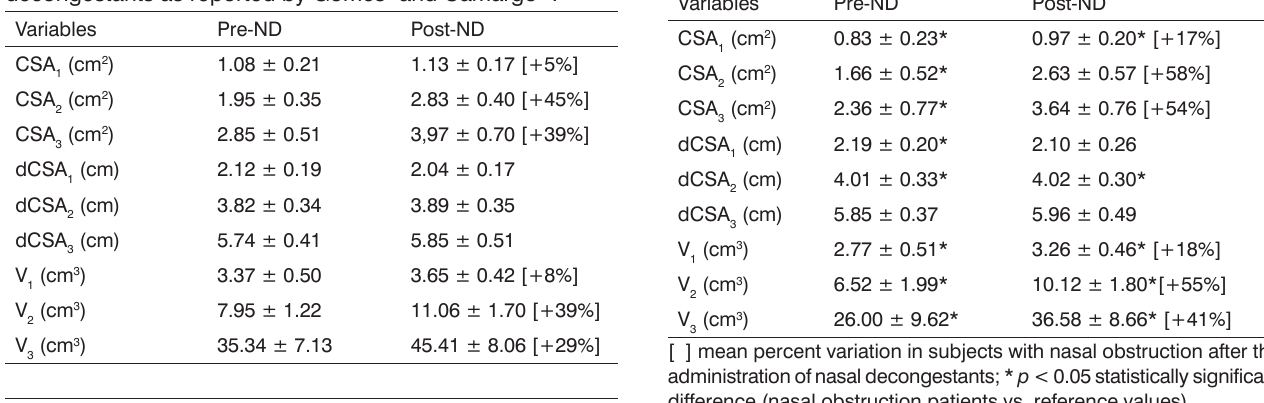
, CSA , CSA ), distances 1 2 3 , dCSA , dCSA ), and nasal volumes 1 2 3